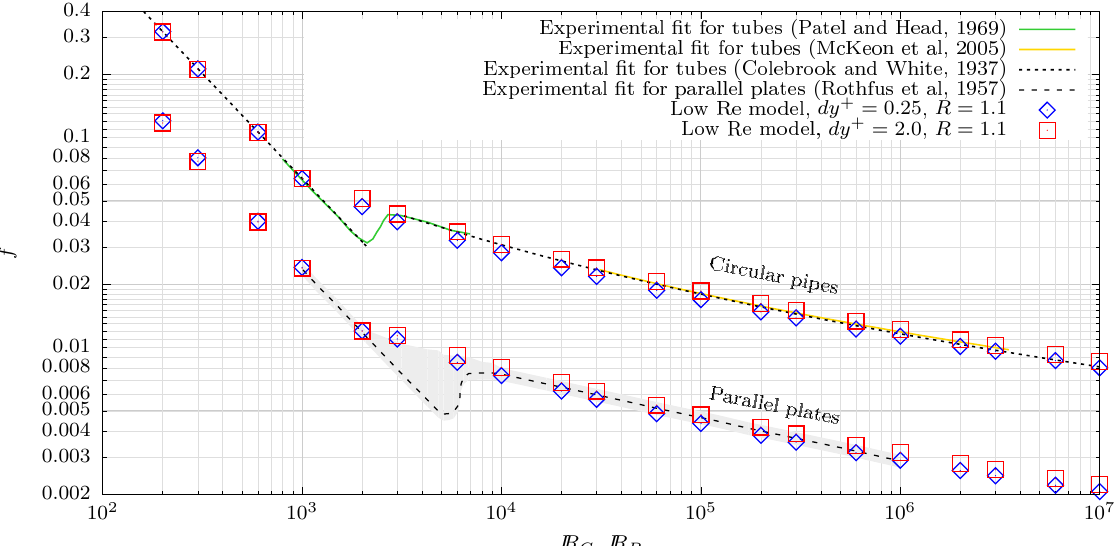
Figure 6: Friction factor from LRN treatment with coarser